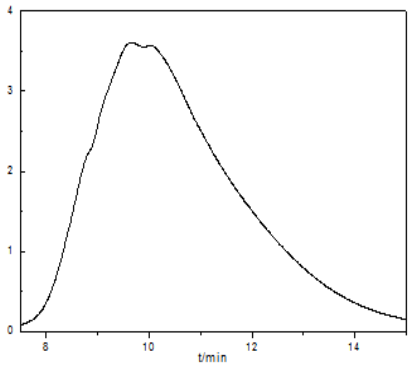
Figure 6. Gel permeation chromatogram of the synthetic copolyether (dissolving with N,N - Dimethylformamide, flow velocity of 1.0 mL/min, column temperature of 30 ° C). 3.2. Properties of Polyurethane Based on Epoxycyclohexane-Epoxychloropropane Polyether Polyol